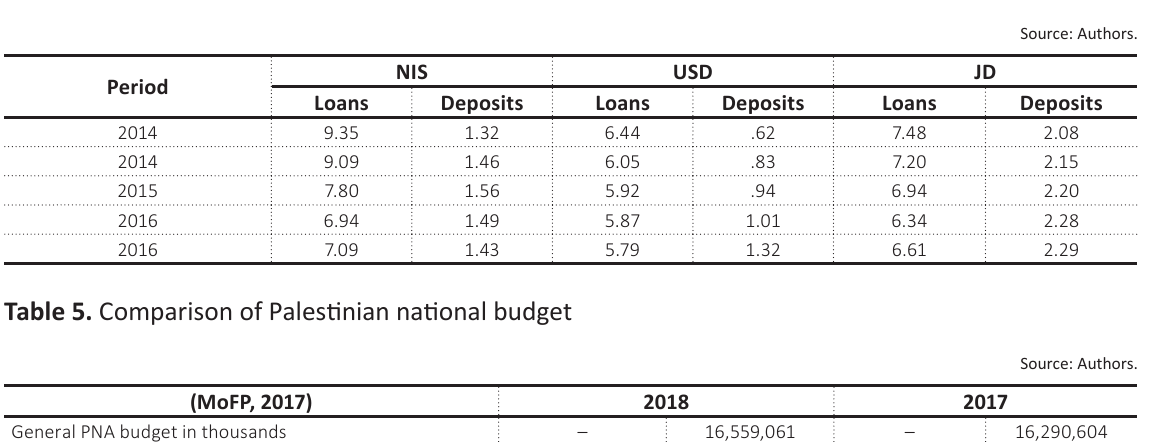
Table 4. Interest rates on loans and deposits during 2016–2017